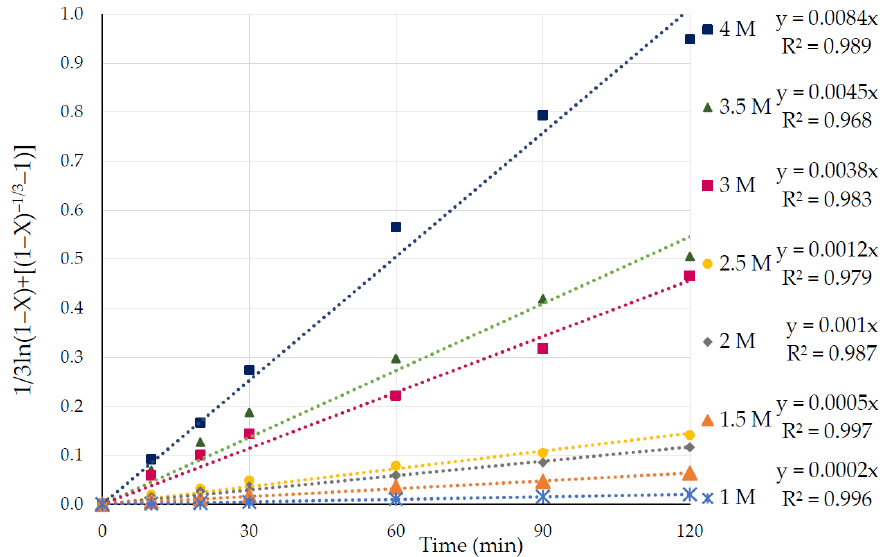
Figure 11. Graph with curves of 1/3ln (1 − X) + [(1 − X) − 1/3 − 1)] vs. time (min) at different concentrations of HNO 3 at a temperature of 65 ◦ C.